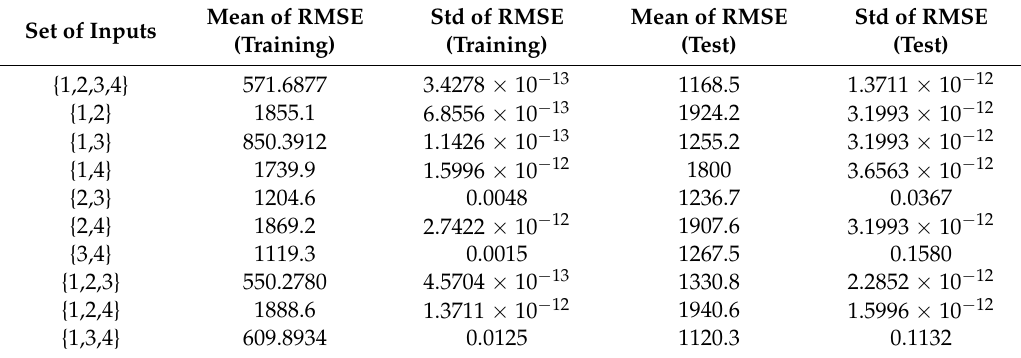
Table 4. Training and test results from Bayesian regularization neural network BRNN with different input combinations.